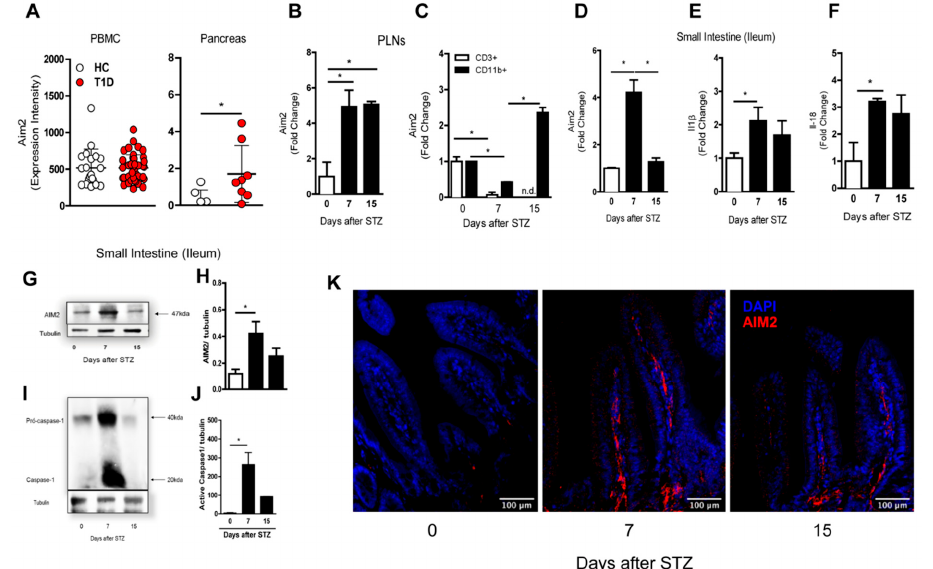
Figure 1. Expression of the AIM2 receptor in the pancreatic lymph nodes (PLNs) and small intestine in the streptozotocin STZ-induced type 1 diabetes (T1D) model. WT mice were injected with STZ (40 mg / kg) or a vehicle solution (VH, non-diabetic, 0 days after STZ) for five consecutive days. The PLNs and small intestine were recovered at 0, 7 and 15 days after the STZ injections. ( A ) The gene expression of Aim2 in the PBMC and pancreatic tissue of T1D patients, obtained from the Gene Expression Omnibus (GSE9006 / GSE72492). The gene expression of Aim2 in ( B ) the PLNs by qPCR and ( C ) CD3 + lymphoid and CD11b + myeloid cells, isolated by FACS from the PLNs from the WT diabetic or nondiabetic mice at 0, 7 and 15 days after the STZ injections. ( D – F ) The gene expression of Aim2, pro-il1 β and pro-il18 in the small intestine of the WT mice at 0, 7 and 15 days after the STZ injections, respectively. ( G – J ) Western blot analysis of the AIM2 and active caspase-1 expression in the small intestine of the WT mice at 0, 7 and 15 days after the STZ injections. ( K ) Immunofluorescence microscopy of AIM2 in the small intestine of the WT mice at 0, 7 and 15 days after the STZ injections (AIM2 staining is represented in red, and DAPI staining is represented in blue). The values are expressed as the mean ± SD. * p < 0.05 was considered statistically significant, when compared with the WT mice at time 0 after the STZ injections. N = 3–6 animals per group. Significant di ff erences between the groups were determined by one-way ANOVA, followed by Tukey’s multiple-comparison